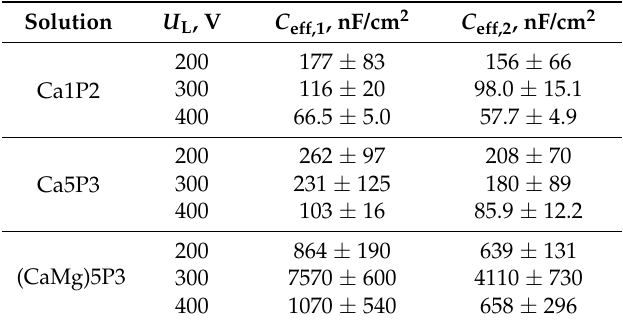
Table 2. Effective capacitances of the PEO coatings on